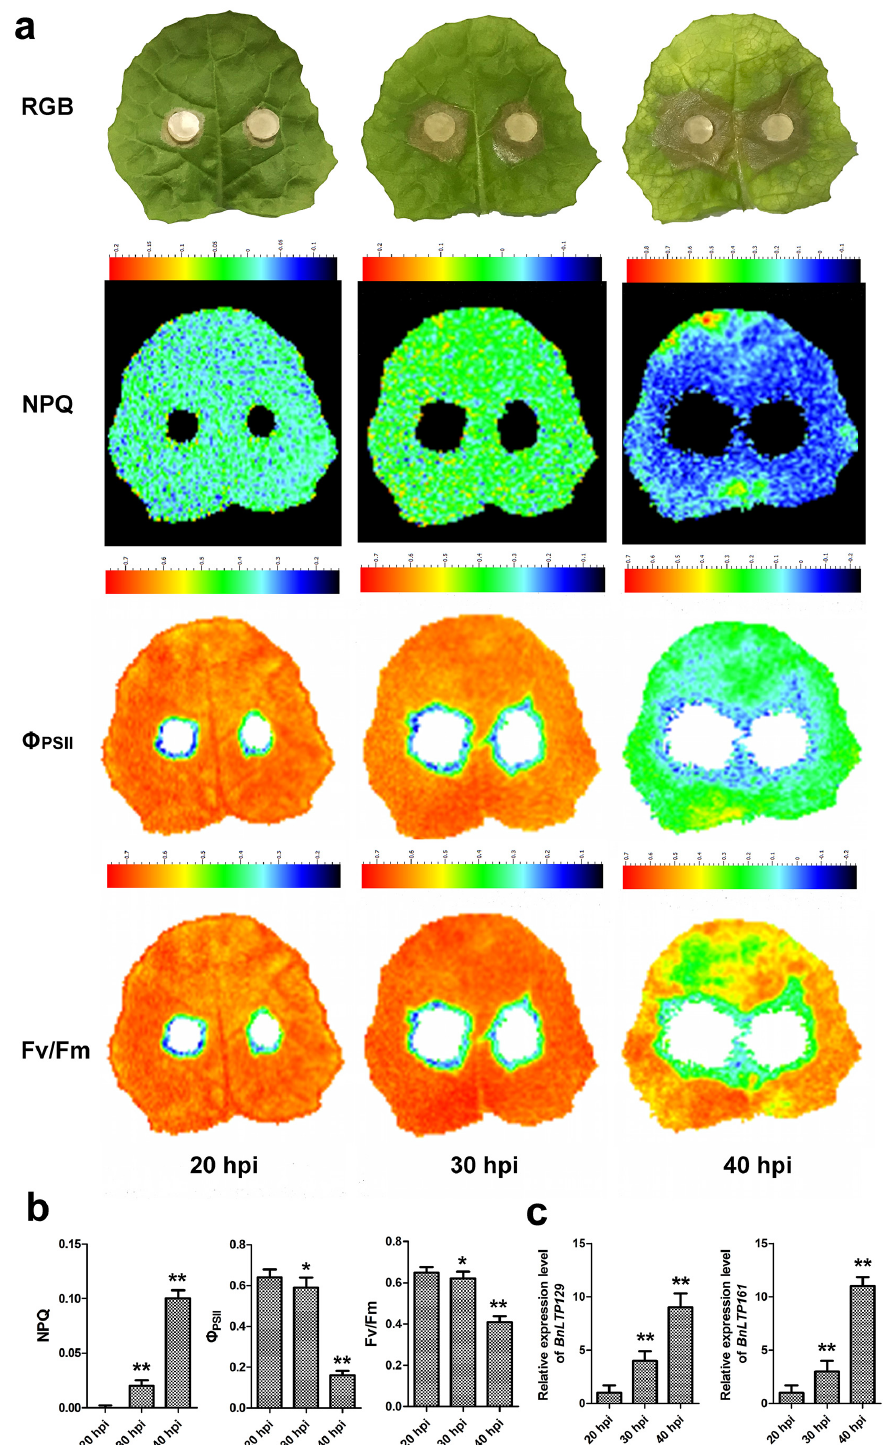
Figure 10. The impact of S. sclerotiorum infection on photosynthesis of rapeseed leaves ( a , b ); and the qRT-PCR expression level of two top Sclerotinia -responsive BnLTP genes, BnLTP129 and BnLTP161 ( c ). Standard images of the RGB, Fv/Fm, Φ PSII and NPQ from S. sclerotiorum -infected rapeseed leaves at 20, 30 and 40 hpi. A false color scale is used for each parameter. The values represent the average ± SD of 3 biological replicates. Fv/Fm, maximum quantum yield of PSII; Φ PSII, effective quantum yield of PSII; NPQ, non-photochemical quenching. * p < 0.05 and ** p < 0.01 compared with samples at 20